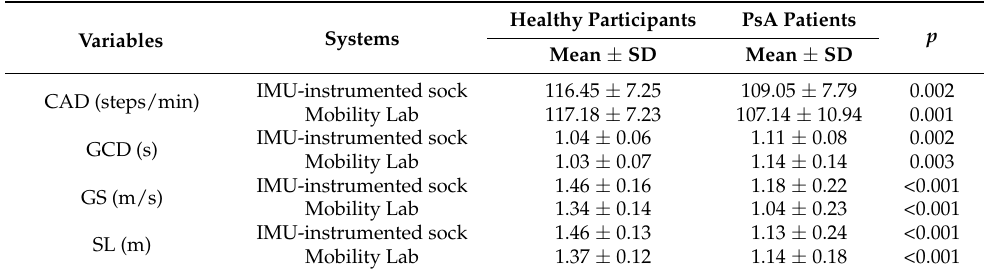
Table 1. Descriptions of the spatio-temporal parameters and the comparison between healthy and PsA